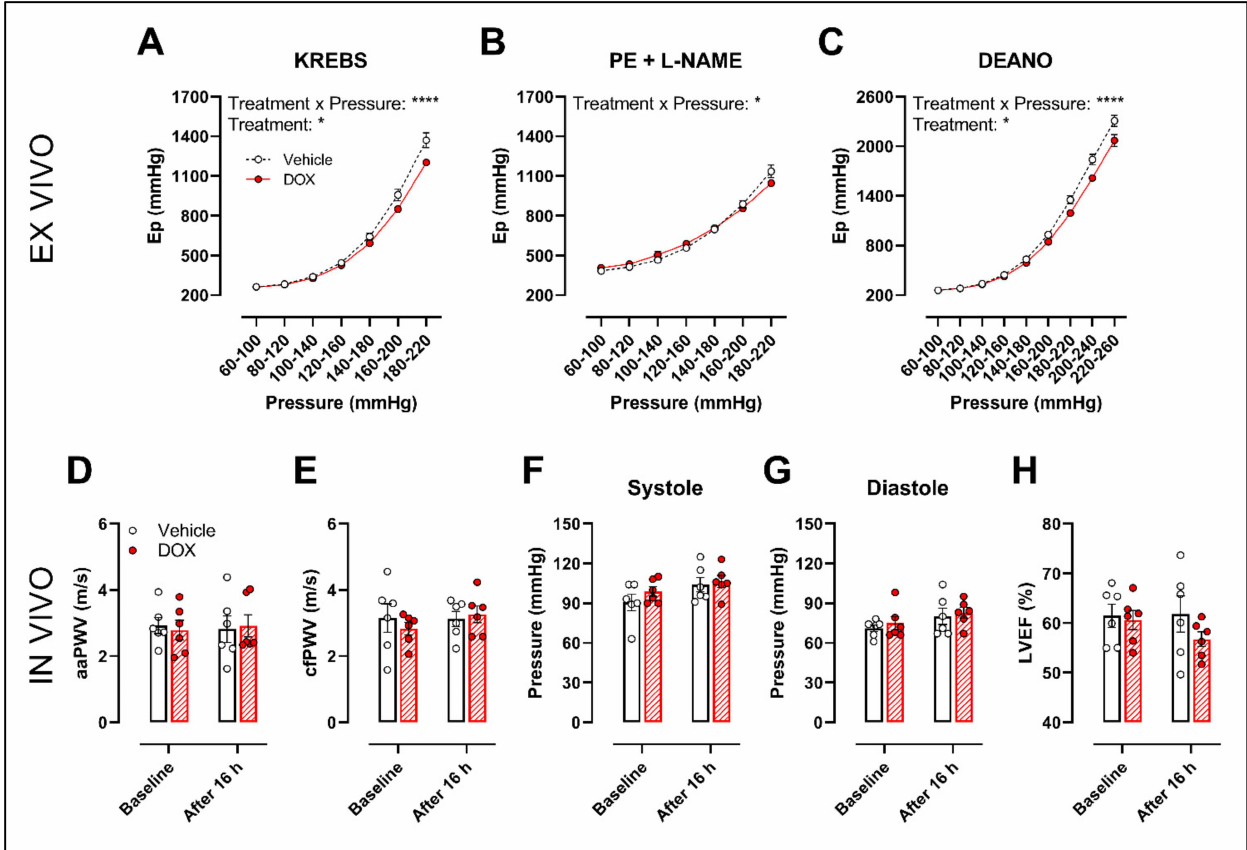
Figure 6. Evaluation of in and ex vivo aortic stiffness, 16 h after in vivo DOX administration. ( A – C ) Ex vivo evaluation of arterial stiffness with ROTSAC set-up. ( D , E ) In vivo evaluation of arterial stiffness with ultrasound imaging ( D ) and tonometry ( E ). ( F ) Systolic blood pressure measurements. ( G ) Diastolic blood pressure measurements. ( H ) Evaluation of LVEF with ultrasound imaging. Ep was lower in the DOX-treated group in a pressure-dependent way under Krebs Ringer conditions ( A ), but the effect was less pronounced in the presence of PE with L-NAME ( B ). Ep in response to DEANO was lower after DOX treatment ( C ). aaPWV ( D ), cfPWV ( E ), systolic blood pressure ( F ), diastolic blood pressure ( G ) and LVEF ( H ) were not affected after DOX treatment. For ( A–H ), repeated measures two-way ANOVA with Šid à k’s multiple comparisons test. *, **** p < 0.05, 0.0001; n = 6 for each